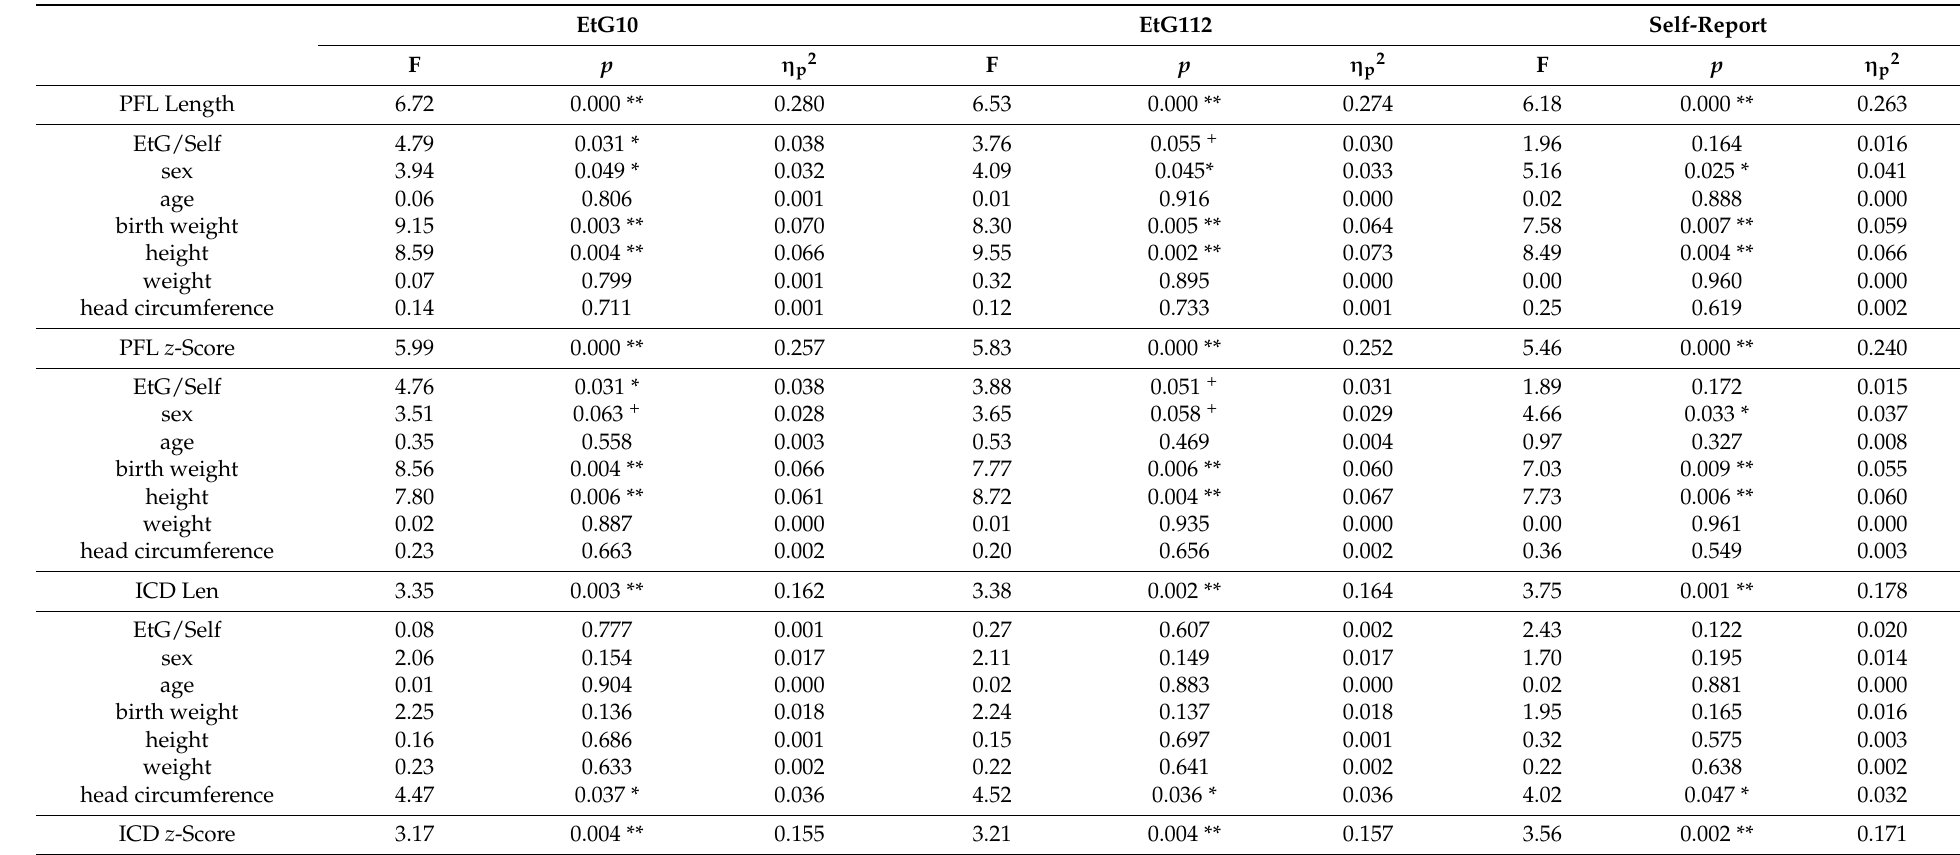
Table 4. EtG-associated differences in facial parameters (ANCOVAs, n = 129, df: 7/121).